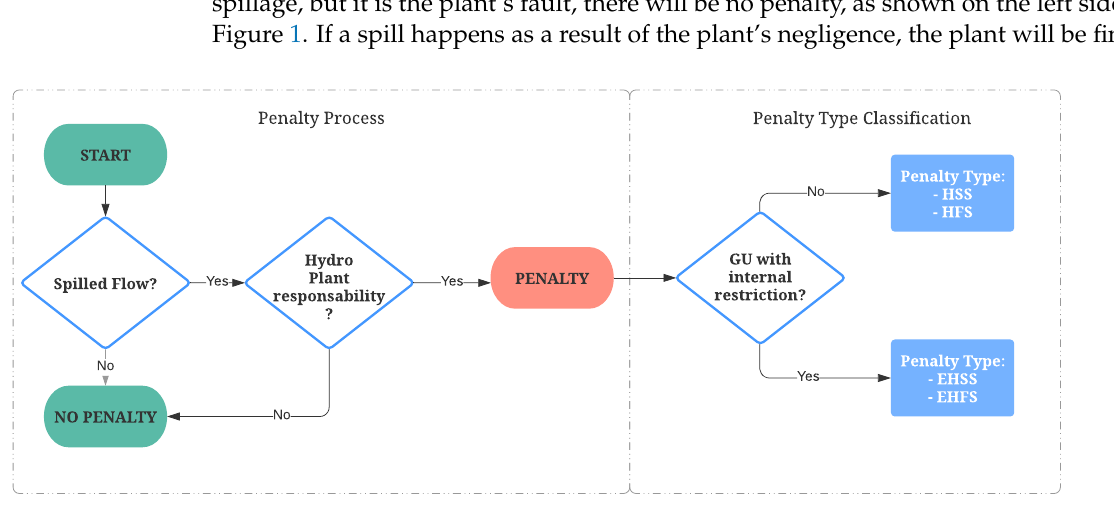
Figure 1. Penalty Rules Flowchart for Power Plants in